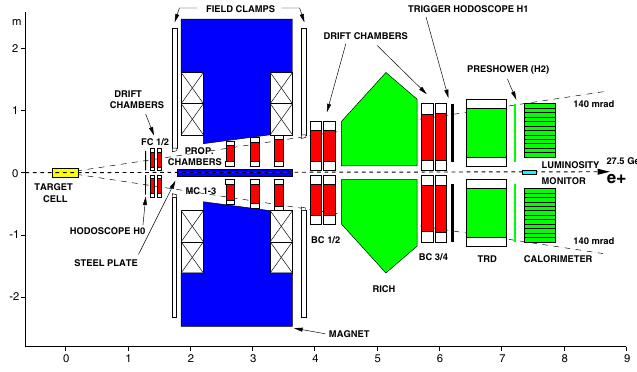
Figure 1. Schematic view of the HERMES